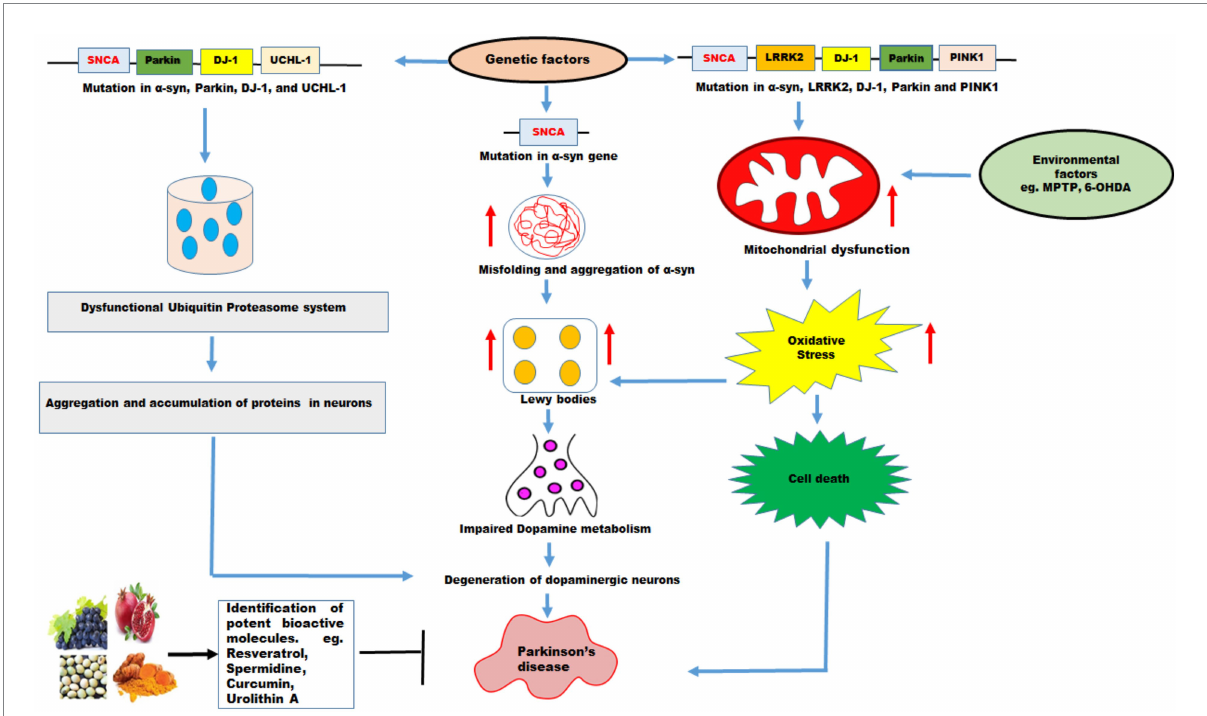
FIGURE 3 The effects of genetic and environmental factors on Parkinson’s disease. Genetic mutations in genes such as SNCA, Parkin, DJ-1, UCHL-1, LRRK2, PINK1 , and environmental factors lead to PD. Mutations in α -syn cause misfolding and increases the aggregation of α -syn which further increase formation of Lewy bodies, impaired dopamine metabolism, and degeneration of DA neurons resulting in PD. Mutations in α -syn , Parkin , DJ-1 , and UCHL-1 impair ubiquitin proteasome system which lead to aggregation and accumulation of proteins in the neurons resulting in degeneration of DA neurons leading to PD. PD pathology has been associated with disruption in mitochondrial dynamics which exhibit mitochondrial dysfunction, increase oxidative stress leading to cell death. Mutations in α -syn, LRRK2, DJ-1, Parkin and PINK1 and environmental factors such as MPTP, and 6-OHDA promote mitochondrial dysfunction and increased oxidative stress leading to cell death. The natural molecules possess variety of health promoting benefits and these molecules function as mitophagy inducers which pharmacologically modulate the mitophagy and might be useful in PD